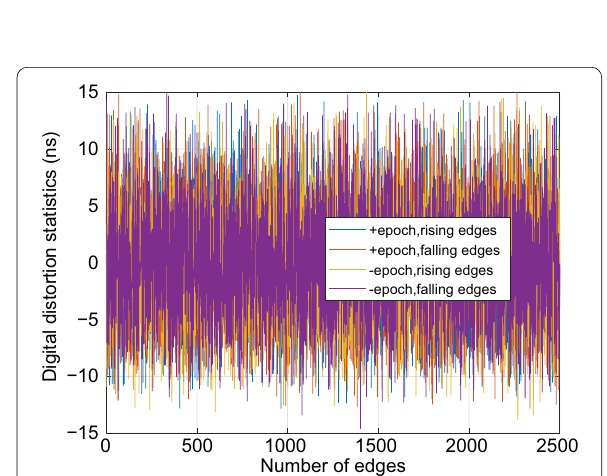
Fig. 18 Digital distortion statistics of BDS-3 GEO-1 PPP-B2b_I